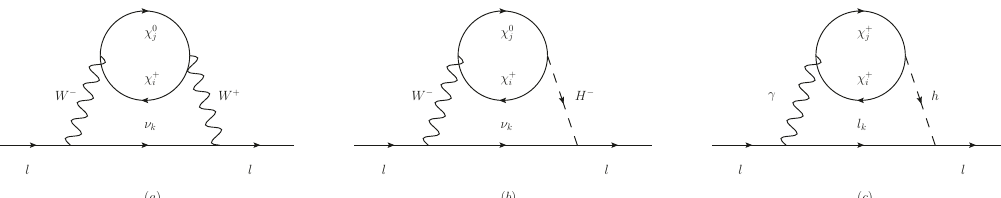
Figure 2 . The two-loop Barr-Zee type diagrams which contribute to the lepton MDM, the corre- sponding contributions to 4 a NP